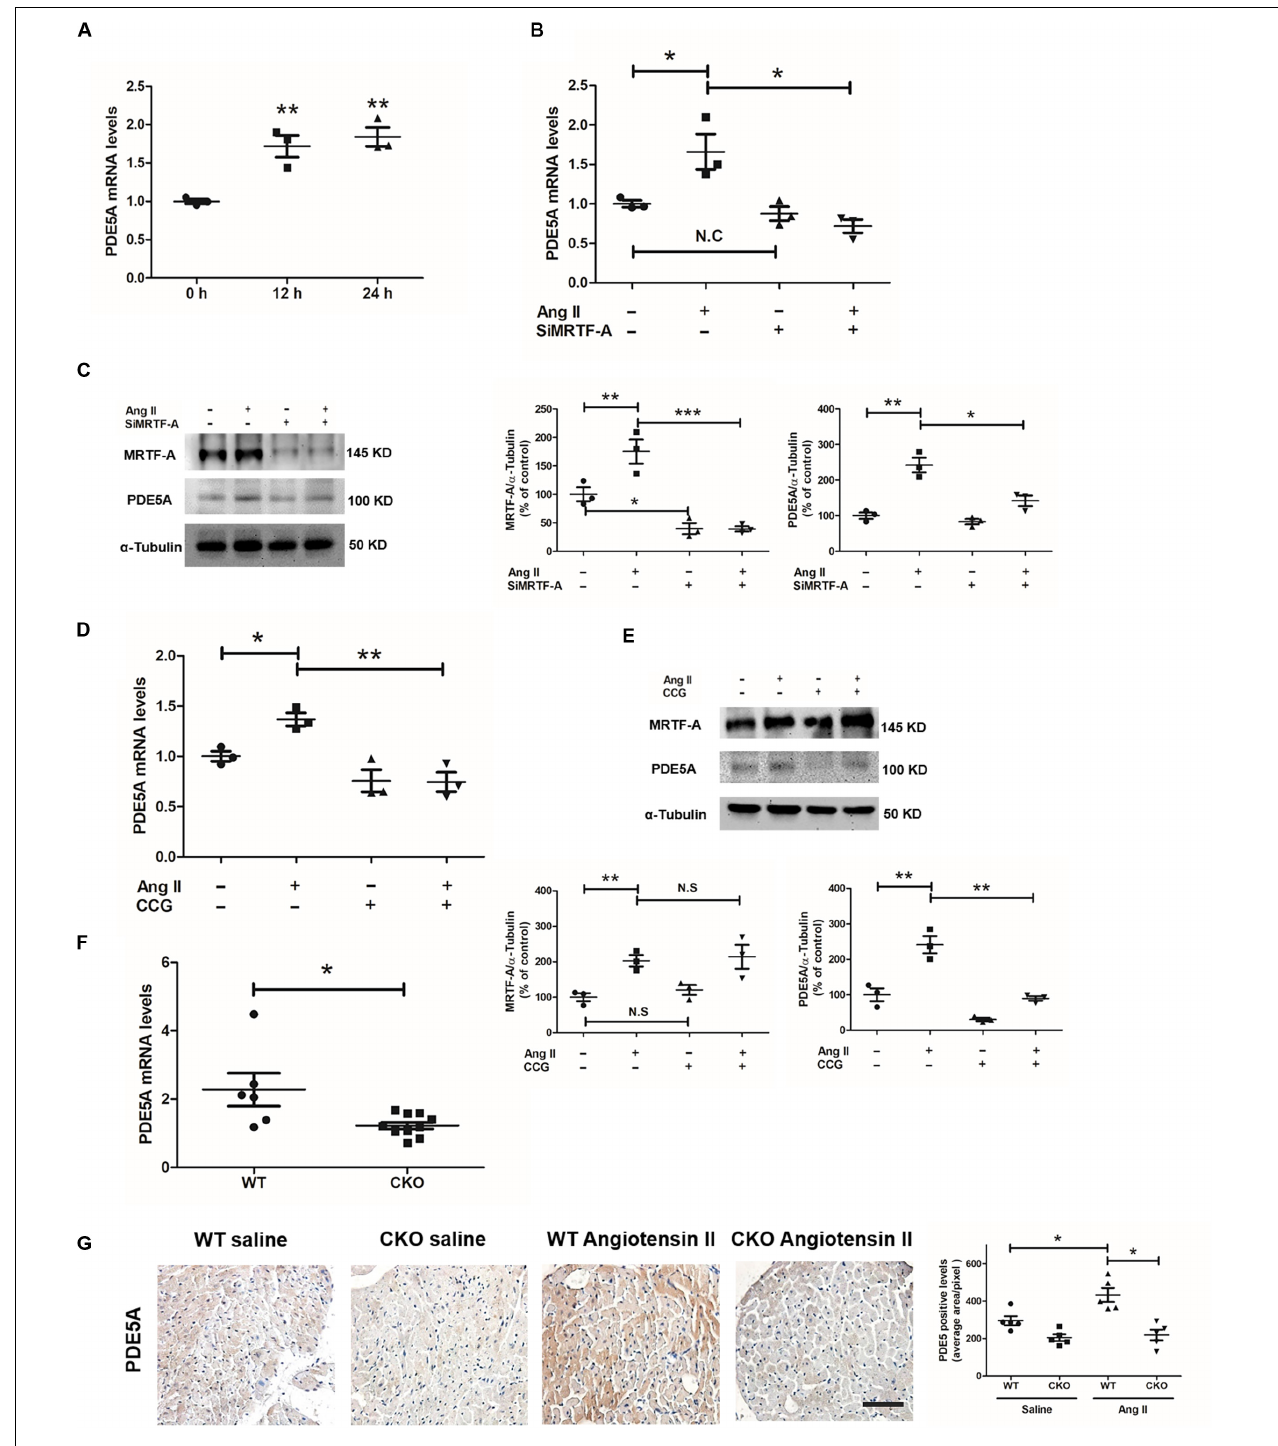
FIGURE 3 | Myocardin-related transcription factor A (MRTF-A) mediates Ang-II-induced phosphodiesterase 5A (PDE5A) expression in cardiomyocytes. (A) H9C2 cells were treated with or without Ang II (1 µ M) and harvested at indicated time points. Gene expression was examined by quantitative PCR (qPCR). (B,C) H9C2 cells were transfected with small interfering RNA (siRNA) targeting MRTF-A or scrambled siRNA (SCR) followed by treatment with Ang II (1 µ M) for 24 h. Gene expression was examined by qPCR and Western blot. (D,E) H9C2 cells were treated with Ang II (1 µ M) and CCG-1423 (10 µ M) for 24 h. Gene expression was examined by qPCR and Western blot. (F) Wild-type (WT) and conditional knockout (CKO) mice were subjected to chronic Ang II infusion for 4 weeks. Cardiac PDE5A expression was examined by qPCR. (G) Immunohistochemistry (IHC) staining for cardiac sections with anti-PDE5A antibodies, Data represent averages of three independent experiments, and error bars represent SEM. * p < 0.05; ** p < 0.01; *** p < 0.001. Scale bar: 50 µ m.